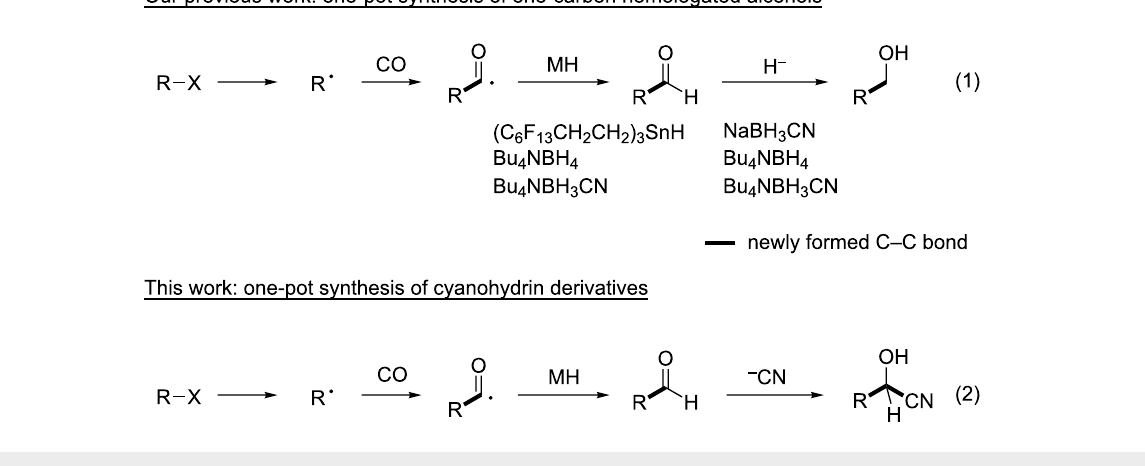
Scheme 1: Sequential radical formylation and derivatization.